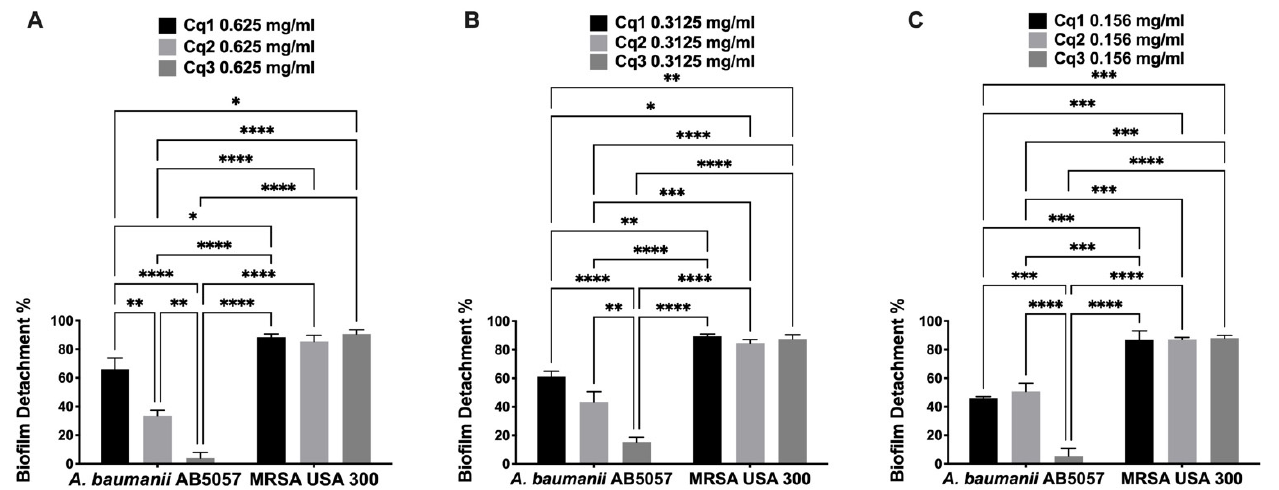
Figure 2. Biofilm detachment activity. Effect of different concentrations ( A: 0.625 mg/mL, B: 0.3125 mg/mL, and C: 0.156 mg/mL) of Caralluma quadrangula extracts (Cq1, Cq2, and Cq3) on previously established MDRAB AB5057 and MRSA USA300 biofilm. Results are expressed as mean biofilm detachment % ± standard error. *, **, ***, and **** indicate that the difference is significant at p < 0.05, p < 0.005, p < 0.0005, and p < 0.0001, respectively (two-way ANOVA, Tukey’s post-hoc test).